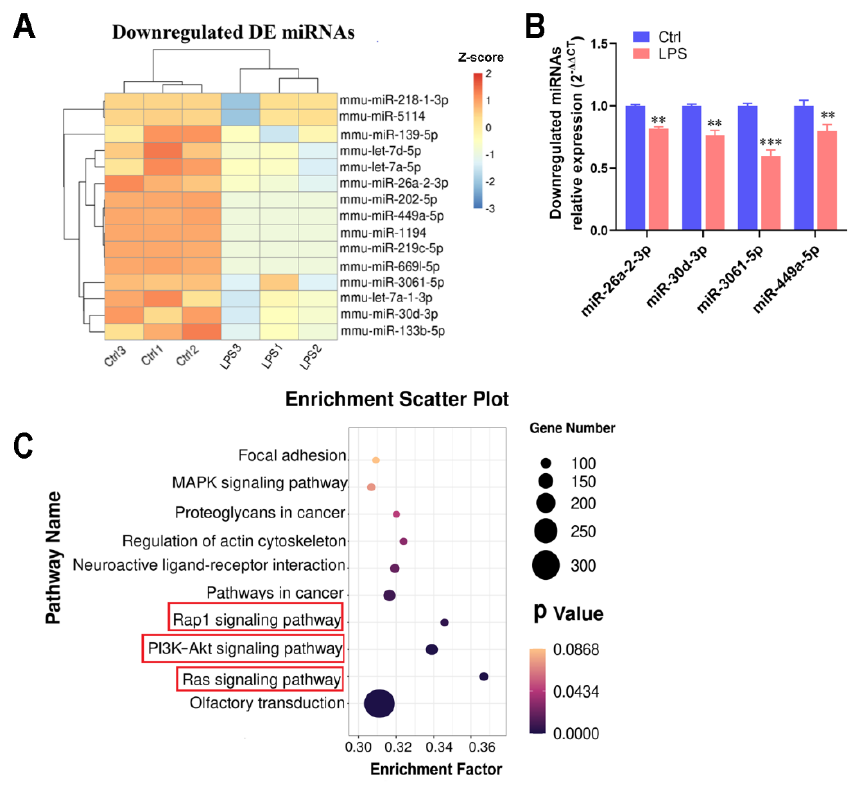
Figure 4. Transcriptome detection of functional miRNAs involved in myotubular cell inflammation. ( A ) Heatmap of 15 downregulated DE miRNAs in myotubes. ( B ) qPCR validation of the highly expressed DE miRNAs (FPKM value > 10 and absolute log2 (fold change) ≥ 1). ( C ) Bubble chart of the top 10 pathways through the targeted gene function enrichment; the red box highlights the pathway associated with inflammation. The data shown are the means ± SEM, n = 3. ** p < 0.01, and *** p < 0.001 vs. control cells. Unmarked graphs show no significant difference.